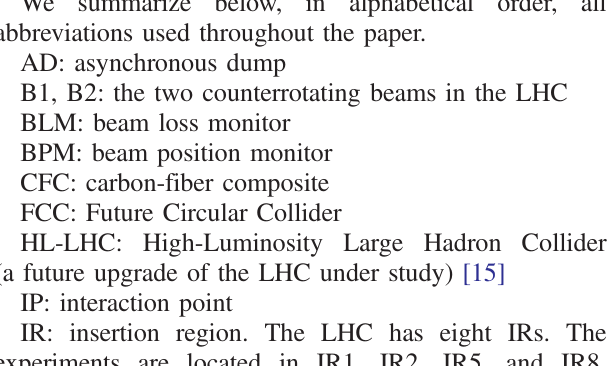
FIG. 9. A schematic view of a collimator protecting an aperture illustrating the variables introduced in Appendix B. The colli- mator is initially centered around the reference orbit, which is present during the collimation setup. At a later time, the orbit can be slightly